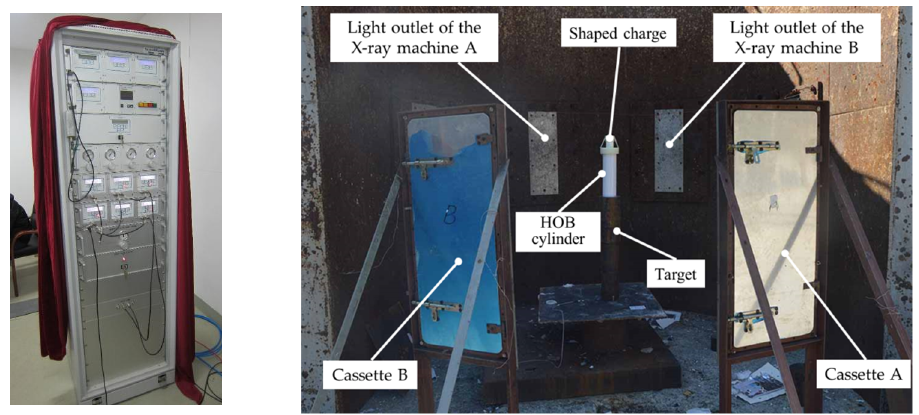
Figure 6. The layout of the X-ray imaging test: ( a ) the X-ray light-emitting controller and ( b ) the layout of the test site.